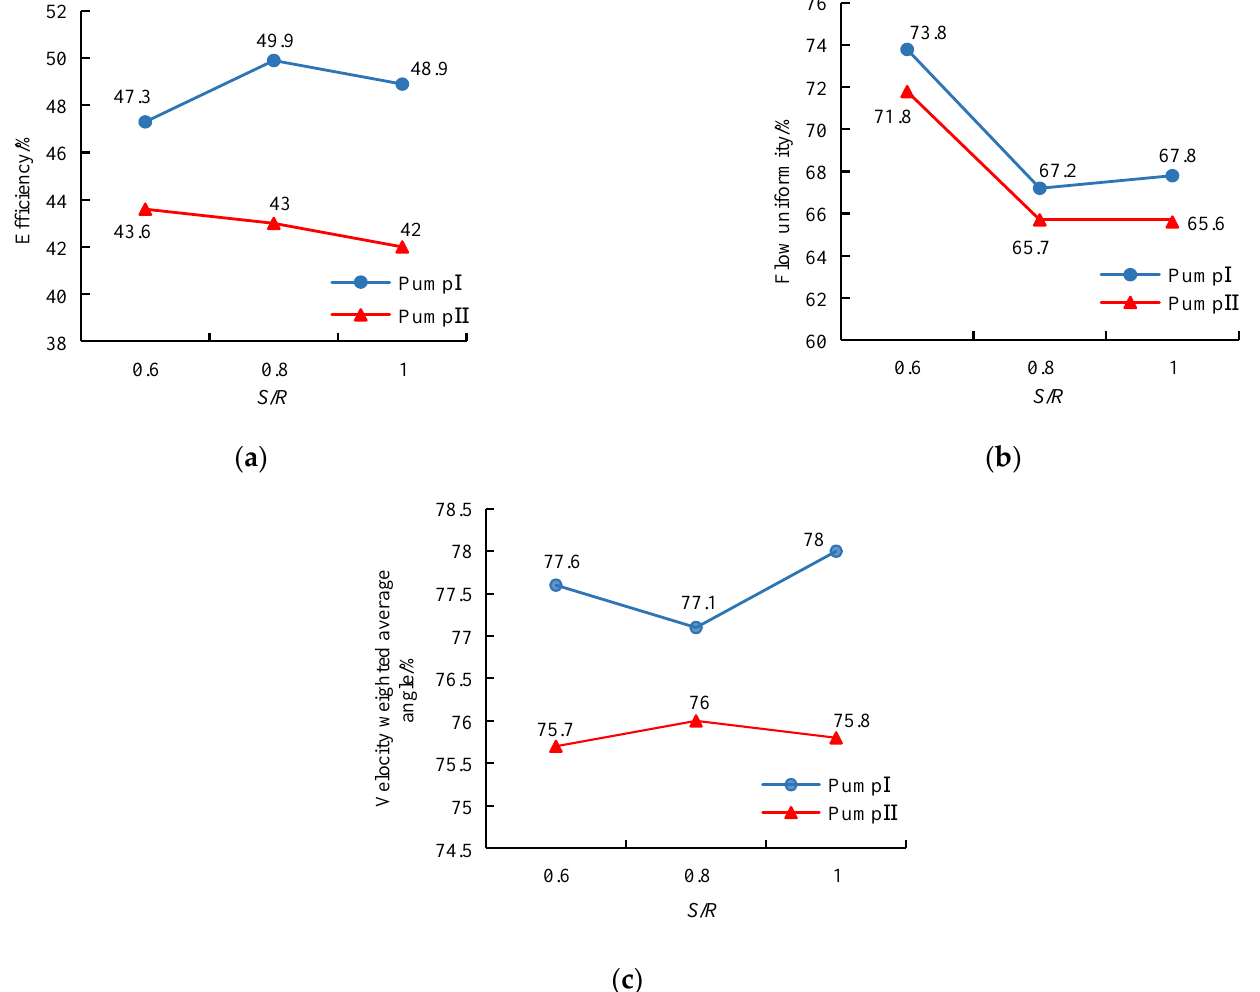
( c ) Figure 10. Streamline and velocity distribution nephogram of Section 1-1 under different S values: ( a ) S = 0.6 R ; ( b ) S = 0.8 R ; ( c ) S = 1.0 R.